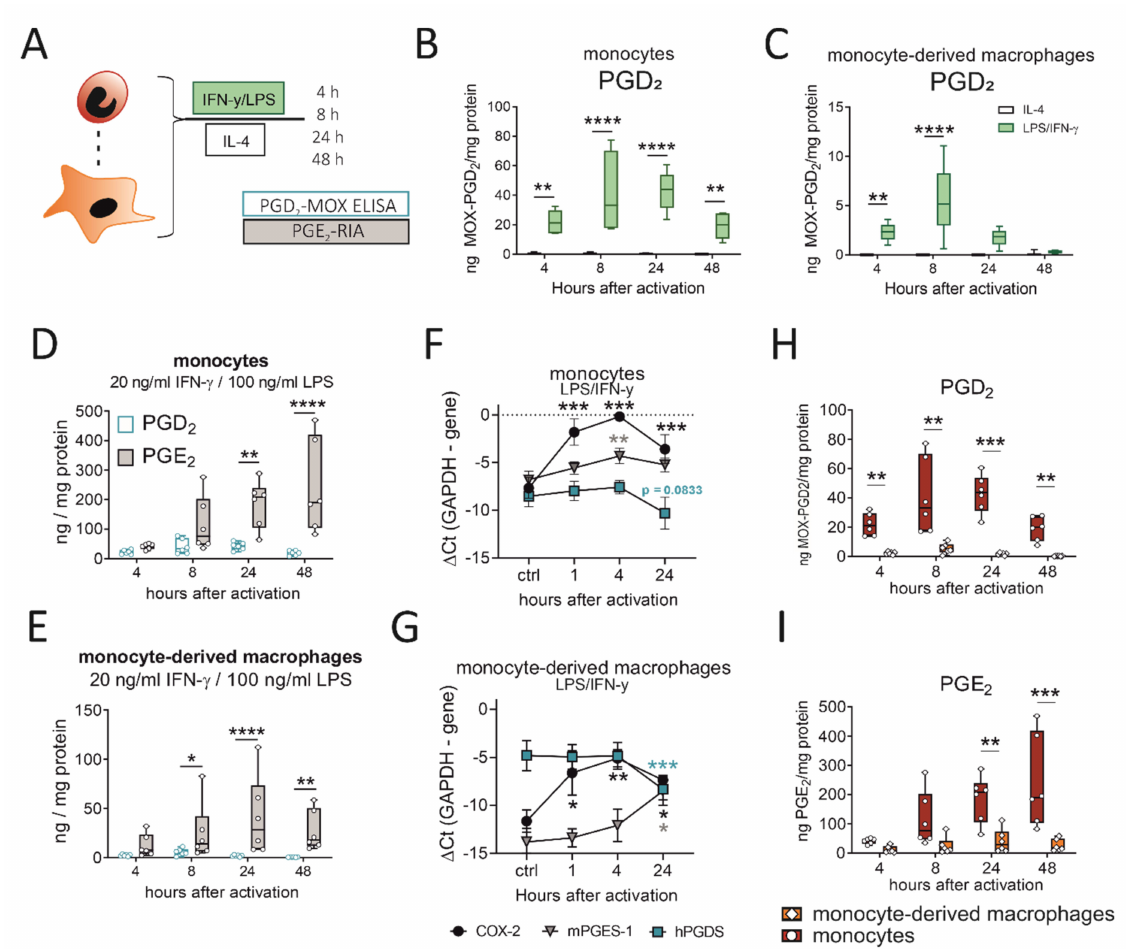
Figure 5. LPS/IFN- γ initiates PGD 2 release by human monocytes/macrophages, while PGD 2 peaks before PGE 2 and monocytes surpass macrophages as a PG source. ( A ) Experimental setup. ( B ) Activation of human peripheral blood monocytes or ( C ) monocyte-derived macrophages with LPS/IFN- γ , but not IL-4, induced significant PGD 2 release. PGD 2 precedes a more extensive release of PGE 2 by ( D ) monocytes and ( E ) macrophages after activation. Transcriptional regulation of COX-2, hPGDS and mPGES-1 in ( F ) monocytes and ( G ) macrophages after LPS/IFN- γ . Human monocytes surpass monocyte-derived macrophages as ( H ) PGD 2 as well as ( I ) PGE 2 sources after LPS/IFN- γ activation. Data are shown as box-and-whisker plot ( n = 6) or line ( n = 6–7; mean + SEM). Two-way ANOVA for repeated measurements with Sidak‘s post hoc test ( B – D , E , H , I ) or one-way ANOVA for repeated measurements with Dunnett’s post hoc test ( F , G , difference to control), * p < 0.05, ** p < 0.01, *** p < 0.001, **** p <